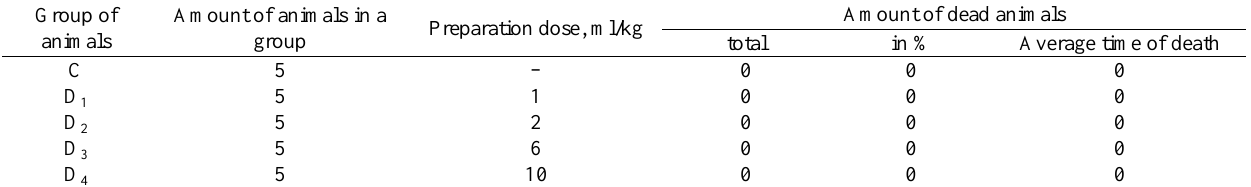
Amount of dead animals